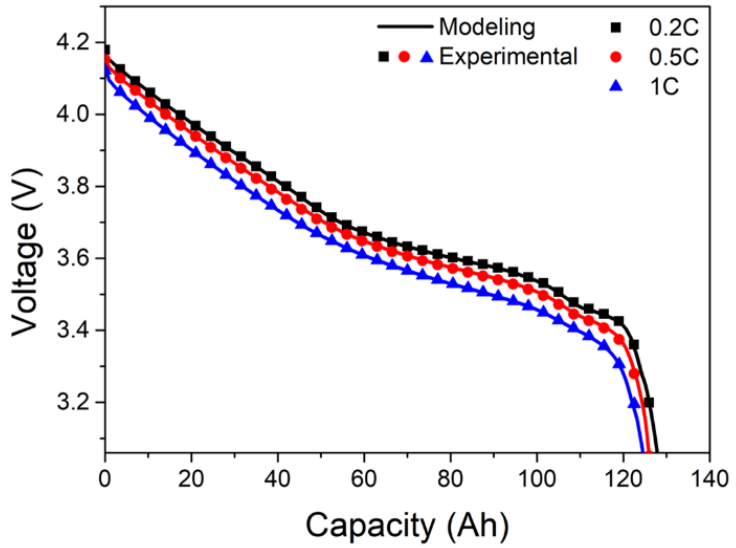
Figure 6. Comparison of discharge voltage behavior of modeling and experimental data at 0.2 C, 0.5 C, and 1 C of LIB strand.